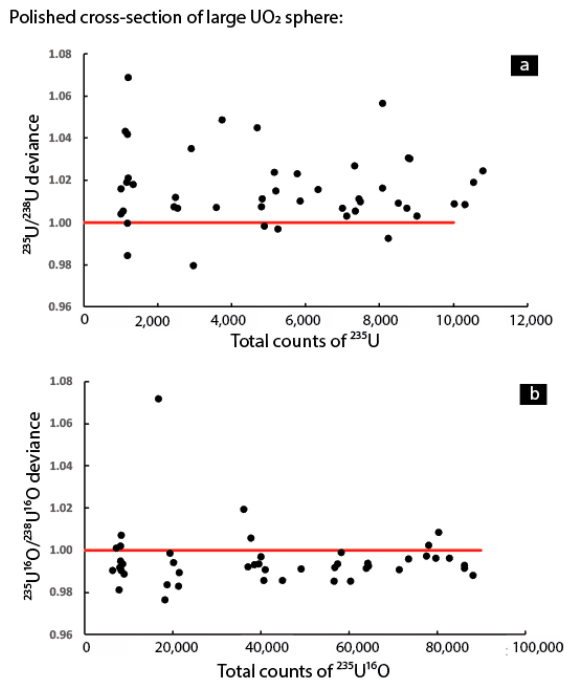
Figure 4. For the UO 2 sphere, each analysis’s deviance in the ( a ) 235 U / 238 U and ( b ) 235 U 16 O / 238 U 16 O ratio relative to the solution MC-ICP-MS value (red line) is plotted as a function of the total number of counts of ( a ) 235 U and ( b ) 235 U 16 O observed during each analysis.